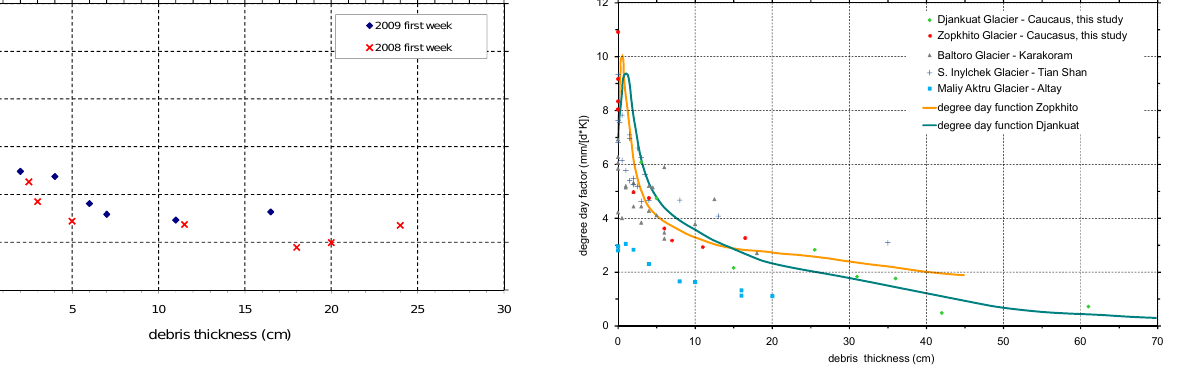
Fig. 10. Degree day factors from different regions (Southern In- ylchek, Hagg et al., 2008, Baltoro; Mihalcea et al., 2006; Maliy Aktru, Mayer et al., 2011), including the manually derived degree day functions for Djankuat glacier and Zopkhito